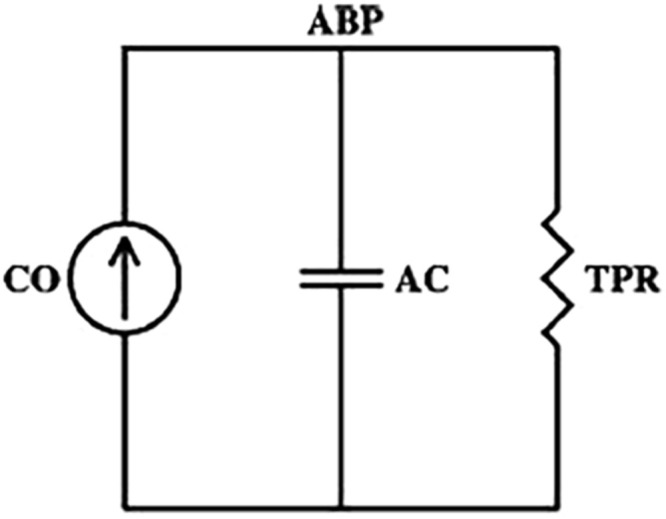
The two-element Windkessel model of arterial tree. CO, cardiac output; ABP, arterial blood pressure; TPR, total peripheral resistance; AC, arterial compliance. According to the model, the time constant τ can be computed as the product of TPR and AC (τ = TPR*AC).